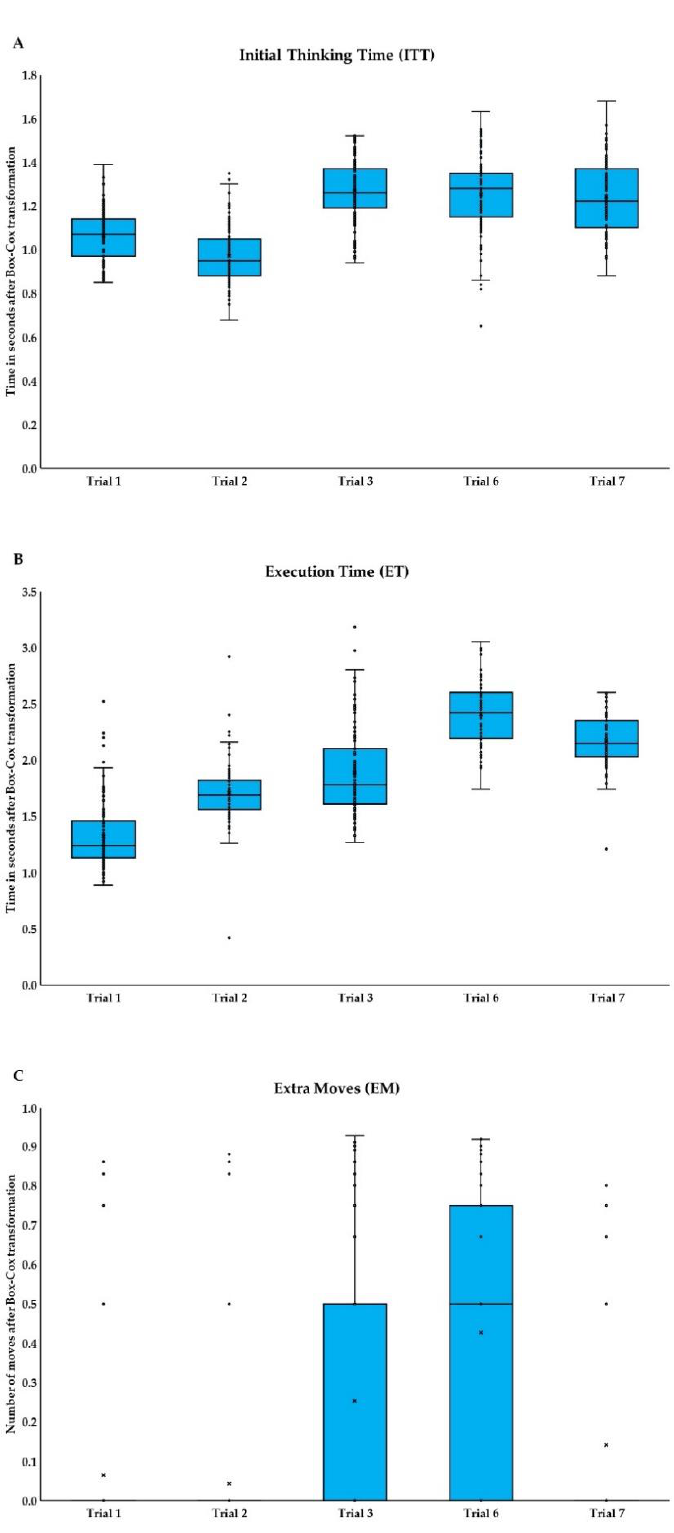
Figure 4. Performance in Tower of London (TOL) task in five trials: ( A ) Initial Thinking Time, ( B ) Execution Time, and ( C ) Extra Moves. Boxplots conventions as in Figure